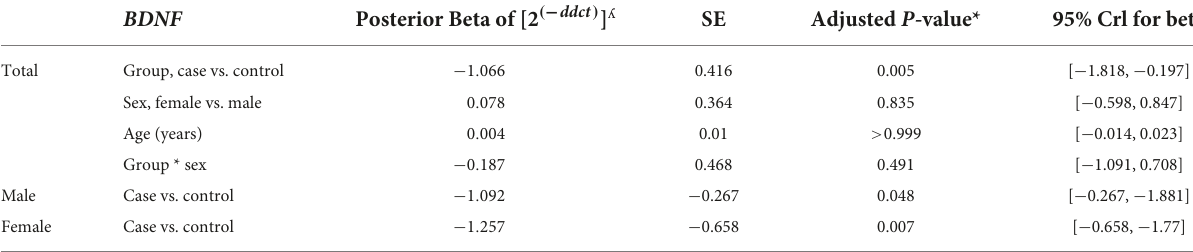
Case vs. control